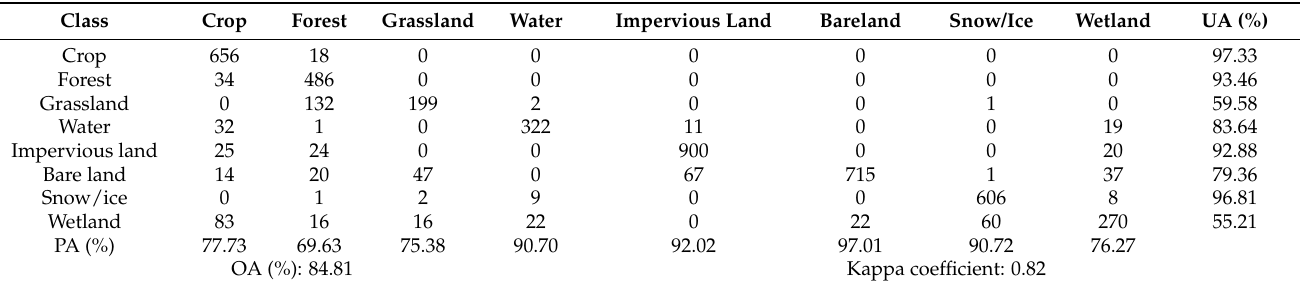
Table 5. Accuracy validation of the Swin UNet model based on visually interpreted samples